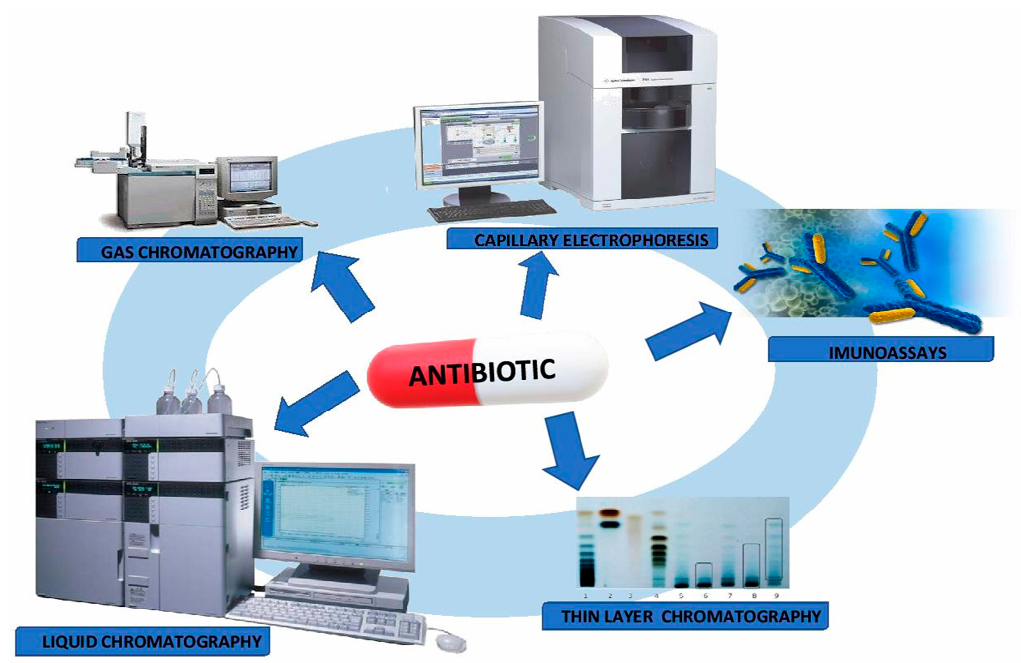
Figure 4. The analytical techniques for determination of antibiotics.